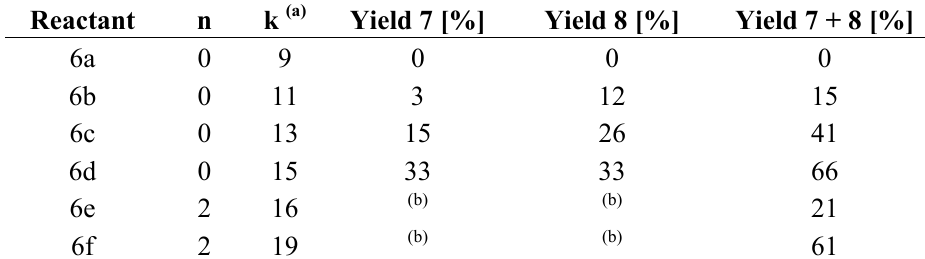
Table 2. Yields of naphthalenophanes 7 and 8